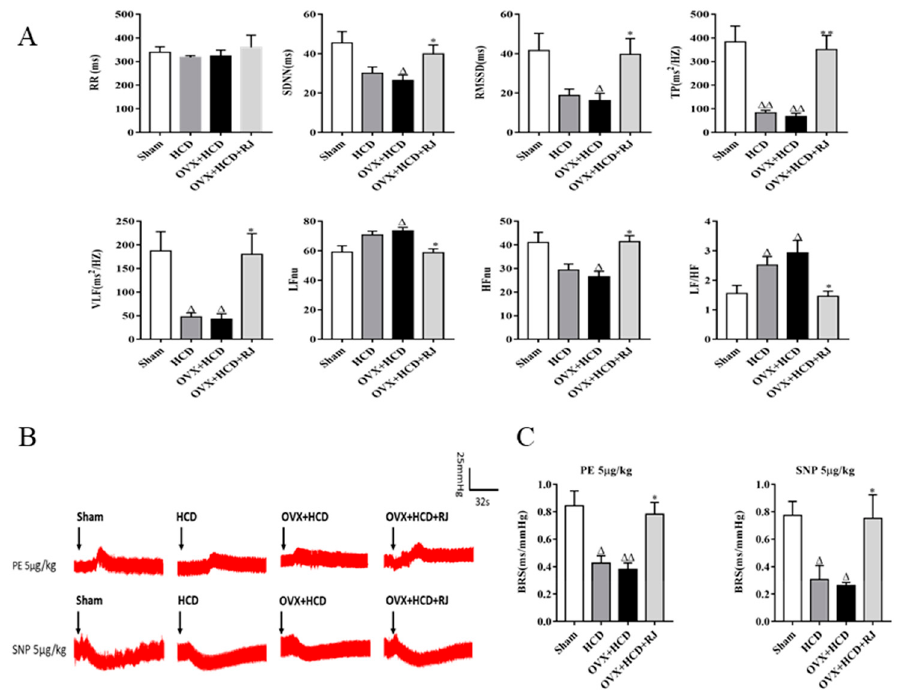
Figure 2. RJ enhanced HRV and BRS in ovariectomized cholesterol-fed rabbits. ( A ) The continuous heartbeat (RR) interval, standard deviation of NN (R-R) intervals (SDNN), the root mean square successive difference (RMSSD), total power (TP), very low-frequency power (VLF), normalized low-frequency (LF) nu, normalized high-frequency (HF) nu, and LF/HF ratio were analyzed in each group. The HRV parameters were significantly decreased in the HCD group and OVX + HCD group, while RJ treatment could significantly recover the balance of HRV. ( B ) Representative blood pressure response curve of each group induced by PE 5 µ g/kg and SNP 5 µ g/kg, and the changes of baroreflex sensitivity (BRS) value induced by PE or SNP ( C ) were observed in each group. The BRS values were significantly decreased in the HCD group and OVX + HCD group, while RJ treatment could significantly increase the BRS values. Data are expressed as mean ± SEM. n = 4–5. Compared with sham group, ∆ P < 0.05, ∆∆ P < 0.01; Compared with OVX+HCD group, * P < 0.05, ** P < 0.01.